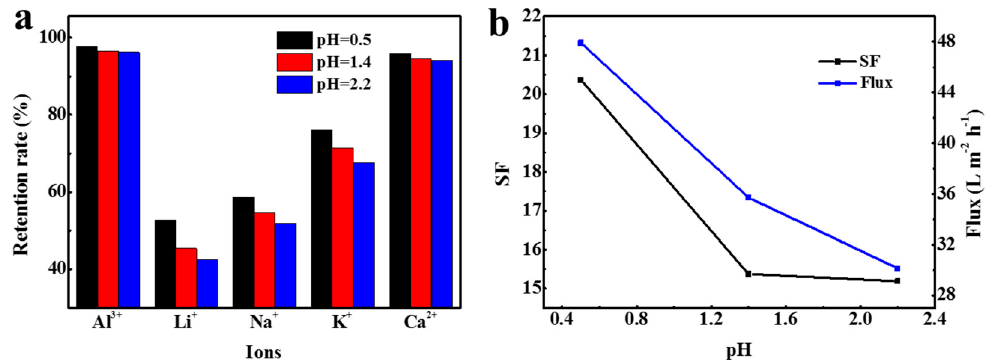
ff ects of pH on ( a ) retention rate, ( b ) separation factor and Figure 15. Effects of pH on ( a ) retention rate, ( b ) separation factor and flux. Figure 15. E